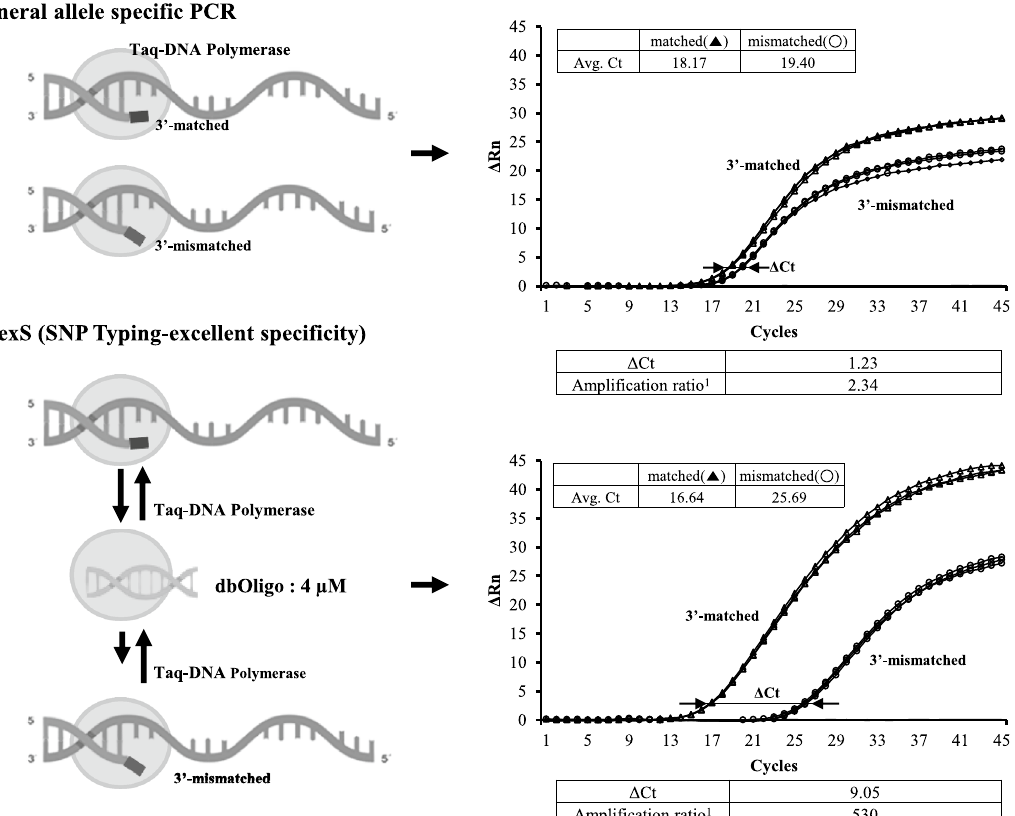
Figure 1. Standard PCR model of DNA polymerase reaction utilizing dbOligo. ( a ) Schematics of general allele specific PCR (AS-PCR). ( b ) Schematics of the SNP Typing -excellent specificity (STexS) PCR. qPCRs were performed with 790-F58-1 for EGFR T790M, and 4 uM of AHP as dbOligo for STexS PCR was